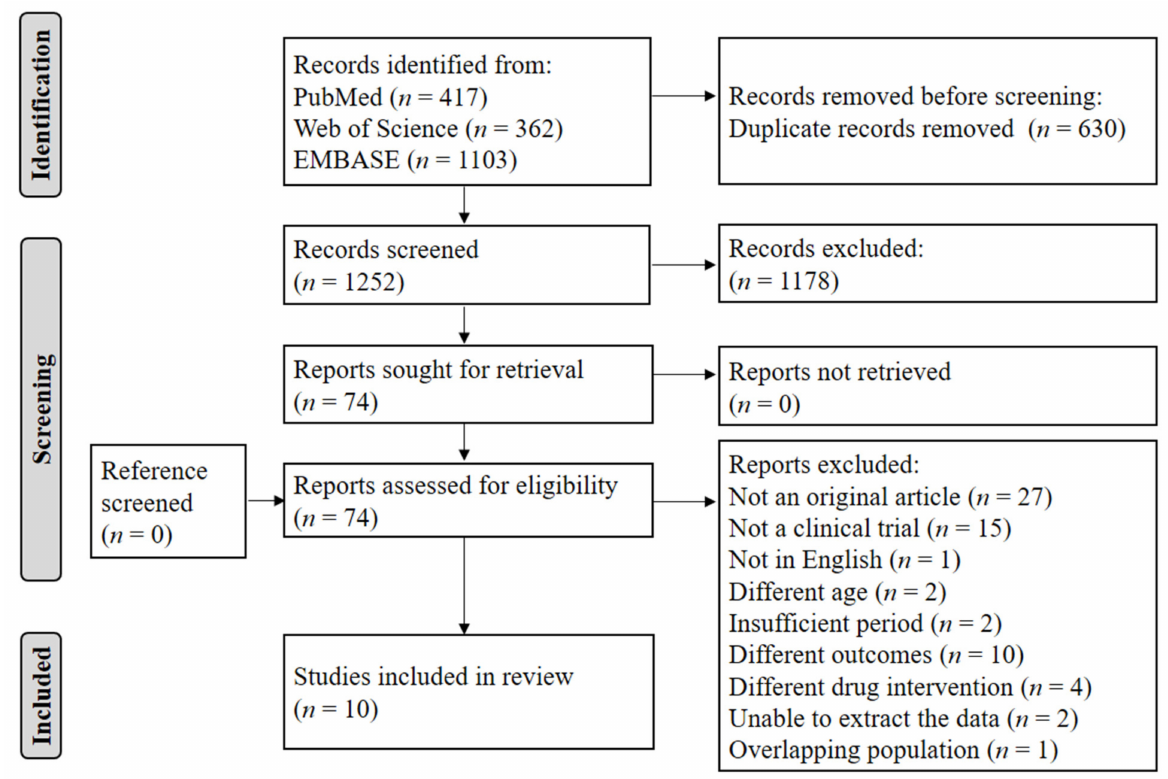
Figure 1. Article selection flow chart.